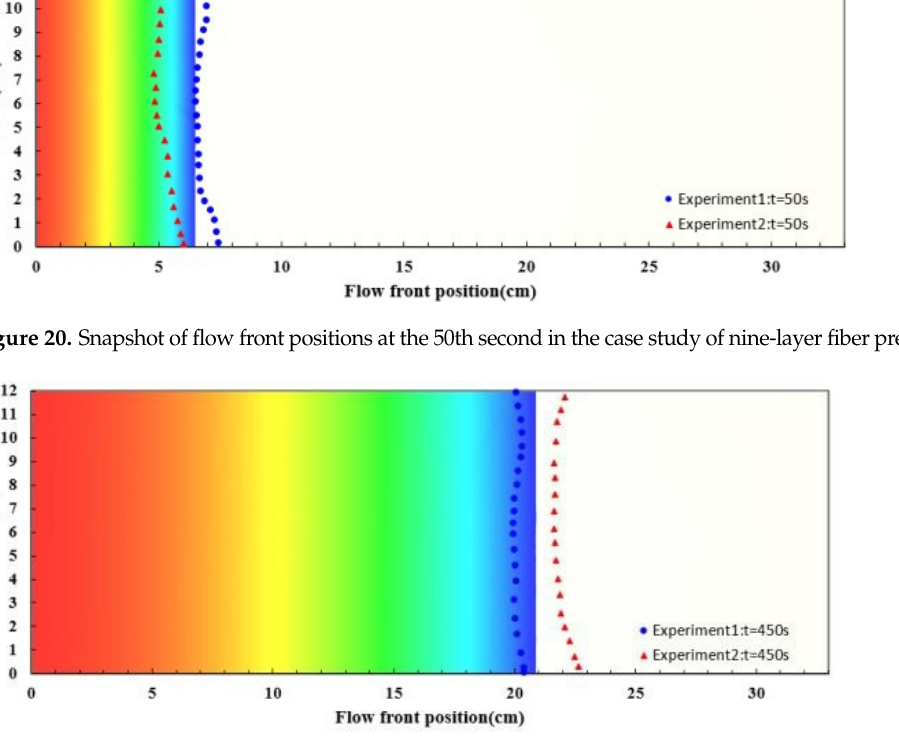
Figure 21. Snapshot of flow front positions at the 450th second in the case study of nine-layer fiber preform. The experiments on the seven-layer fiber preforms were verified in the similar